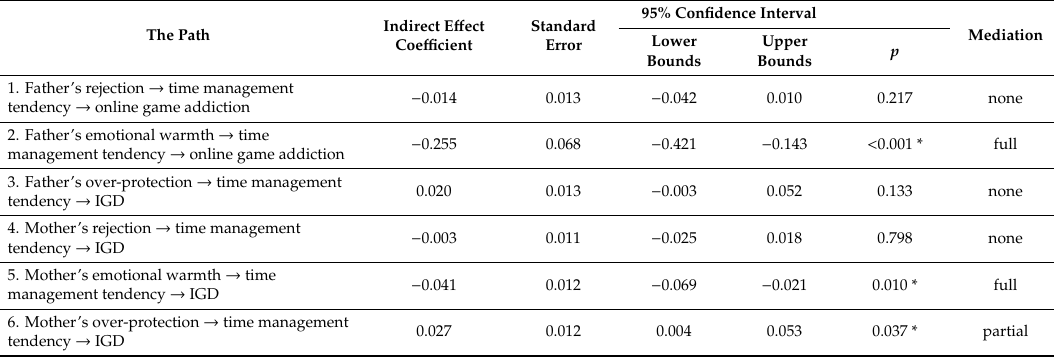
Table A1. Mediating E ff ect of Time Management